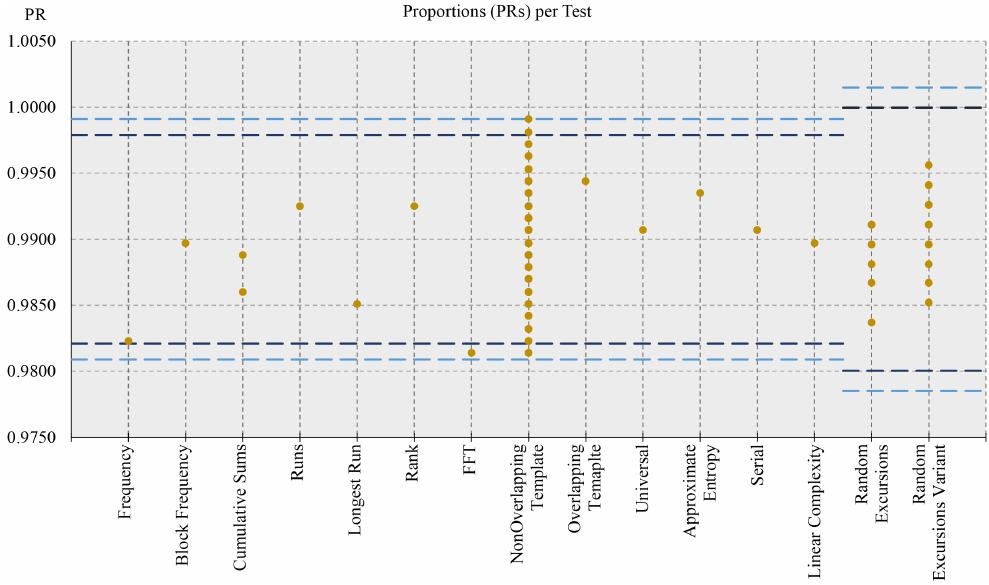
Figure 7. Graph of the results for the PR metric for the tested DRBG [19,20]. The dark golden points represent the PR values for each test or sub-test, and the blue dashed lines represent the boundaries of the confidence interval(s). The widest confidence interval is that of the original NIST STS suite, while the narrowest one is that proposed by the authors of the Fast NIST STS.